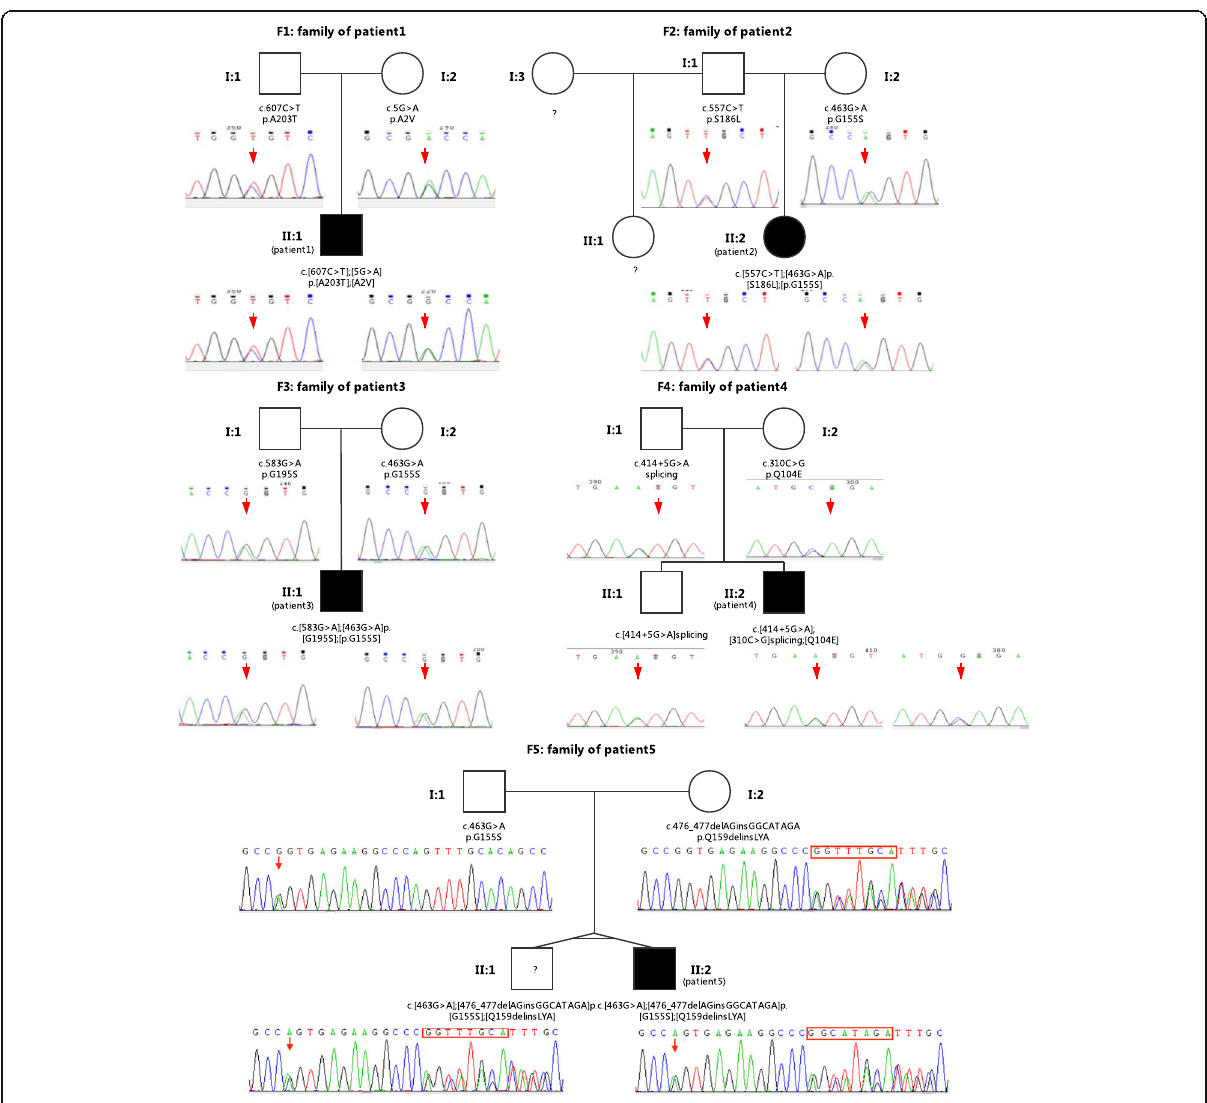
Fig. 3 Genograms with Sanger confirmation results for the five studied